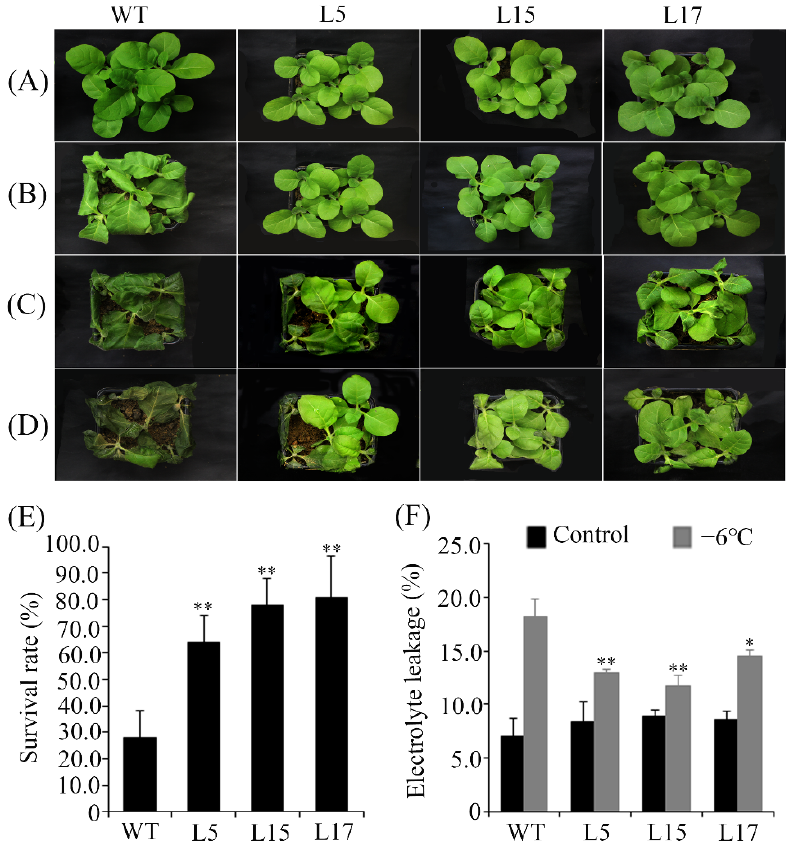
Figure 6. Phenotypic and electrolyte leakage analysis of CsCBF2 -overexpressing transgenic plants under freezing stress conditions. Significant differences between WT and transgenic plants under control and freezing conditions are indicated by * p < 0.05, ** p < 0.01; Student’s t -test. ( A – D ) respec- tively displays the phenotype of WT and CsCBF2 ‐ OX L5, L15, L17 before freezing treatment, after 0 °C freezing treatment for 5 days, after − 2 °C freezing treatment for 5 days, and after transferred back to normal growth conditions and restored growing for 5 days. ( E ) The survival rates of WT and CsCBF2 ‐ OX L5, L15, L17 after transferred back to normal growth conditions and restored growing for 5 days. ( F ) The electrolyte leakage analysis of WT and CsCBF2 ‐ OX L5, L15, L17 under normal growth conditions (control) and after − 6 °C freezing treatment for 2 h.